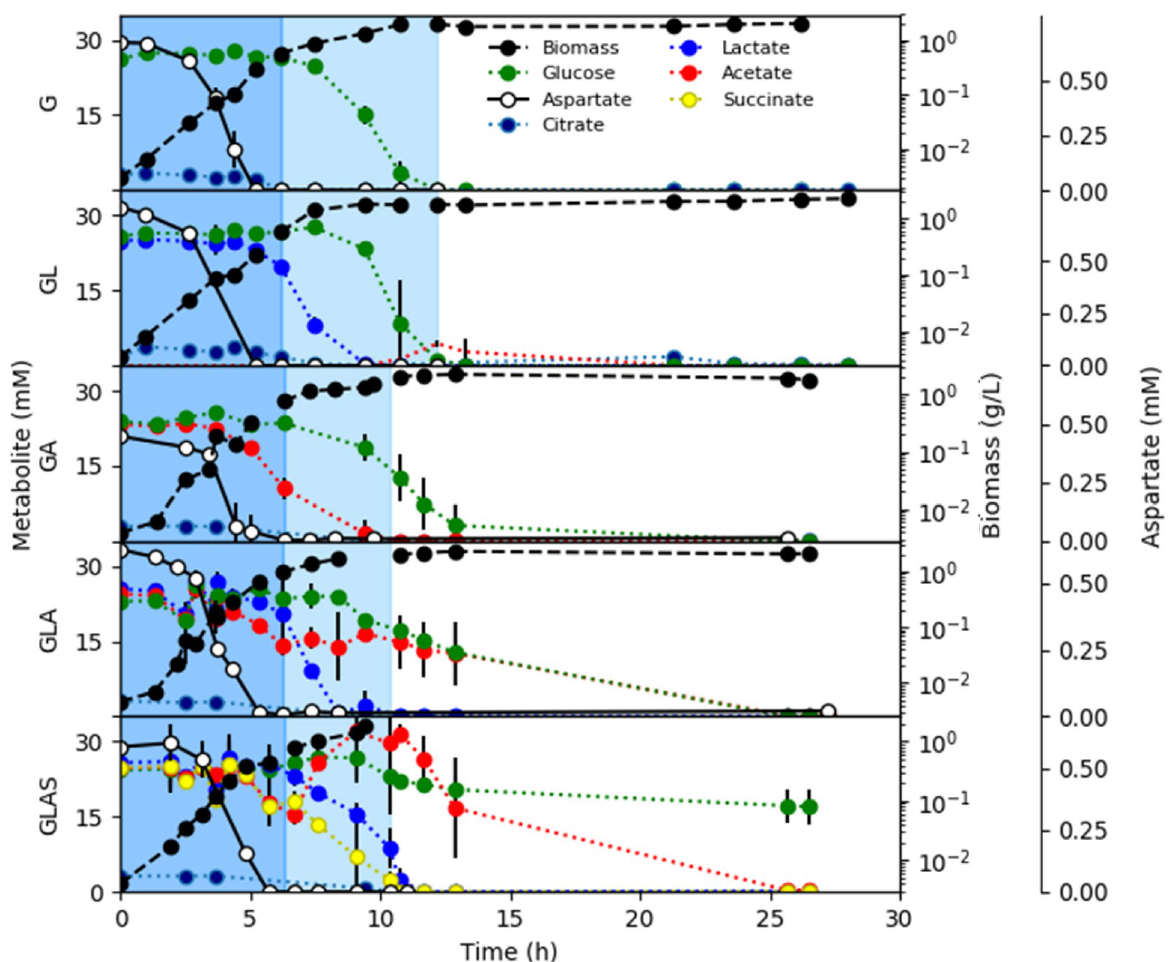
Figure 2. P. aeruginosa 215 substrate utilization order during batch growth in chemically-defined media. Panels plot biomass and substrate concentrations as a function of time for five medium configurations supplemented with different carbon sources at a concentration of 22 mM each. G = glucose, GL = glucose and lactate, GA = glucose and acetate, GLA = glucose, lactate, and acetate, GLAS = glucose, lactate, acetate, and succinate. Aspartate concentration (second y-axis) is plotted as a representative top tier amino acid. Cultures demonstrated two exponential growth phases highlighted with different background shading. Medium composition and additional data for each culture can be found in the supplementary material. All substrate values are averages of three biological replicates and two technical